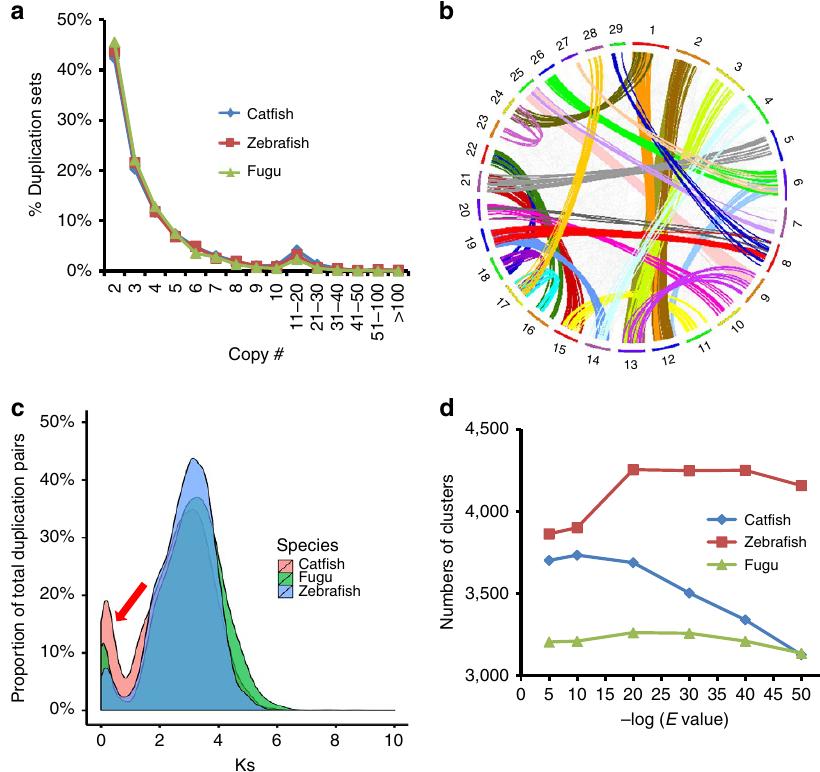
Figure 3 | Characteristics of duplicated genes in the channel catfish genome. ( a ) Comparison of gene copy numbers of duplicated genes among catfish (blue), zebrafish (orange) and fugu (green); ( b ) Interchromosomal duplicated channel catfish genes, likely derived from teleost-specific genome duplication. Numbers are chromosomes and coloured lines represent at least 25 duplicated gene pairs; ( c ) Comparison of duplicated genes in channel catfish, fugu and zebrafish, highlighting recent lineage-specific duplication in channel catfish as specified by the red arrow. ( d ) Duplicated gene clusters in zebrafish, fugu and channel catfish as a function of sequence similarities, noting the sharp splitting of duplicated clusters in channel catfish with higher e-values, suggesting a higher proportion of rapidly evolving duplicated gene clusters in the channel catfish